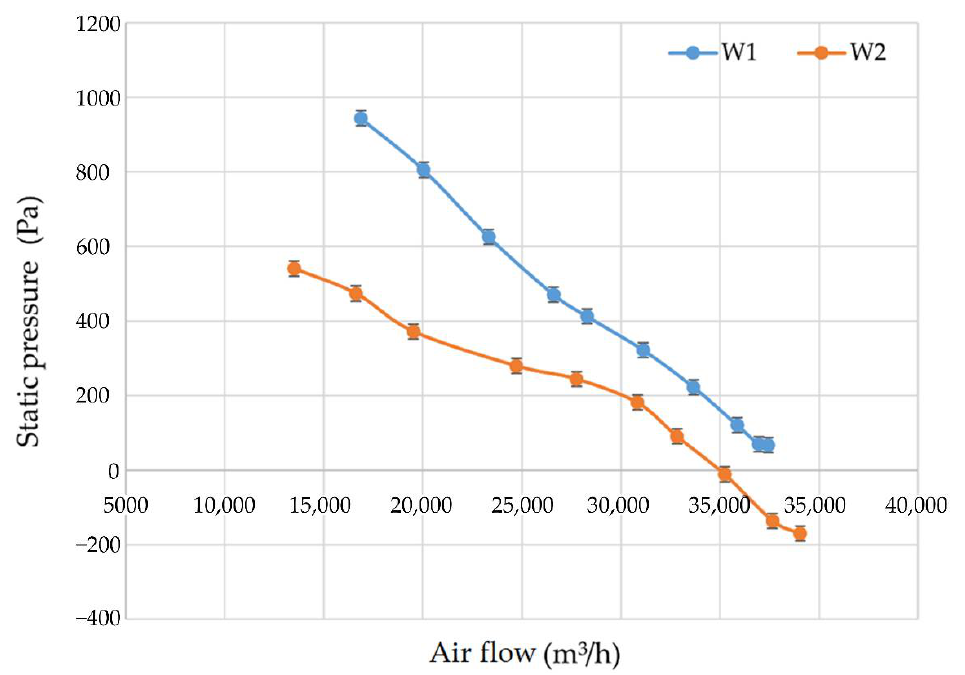
Figure 10. Characteristics of the volume of air flow as a function of static pressure, examined via Method A.